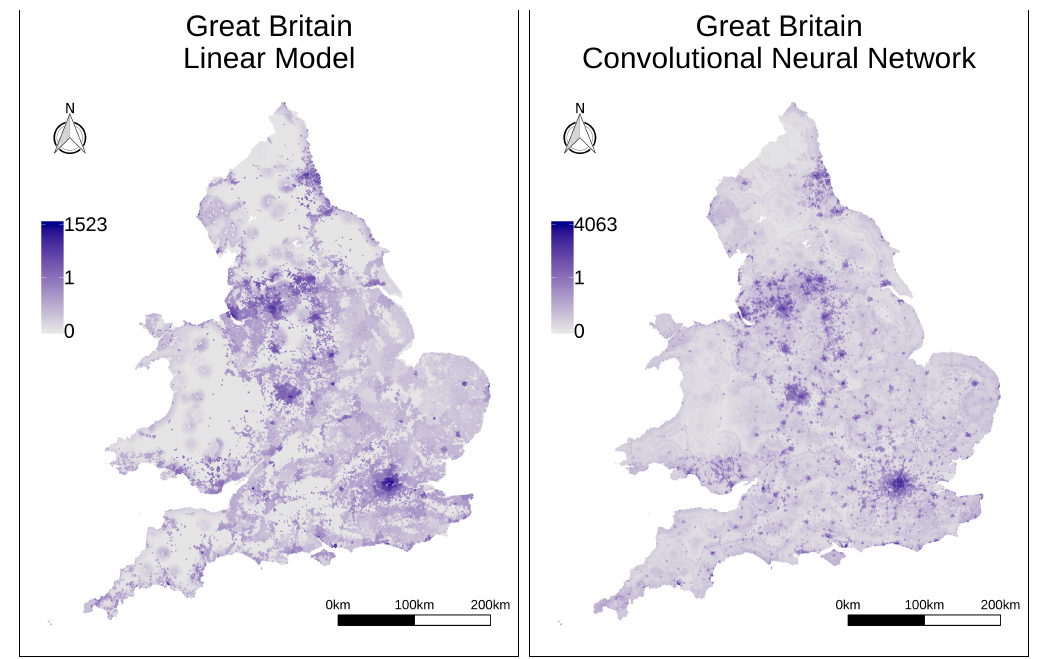
Figure 8. Comparison of two different methods in the disaggregation of historical population counts for the territory of Great